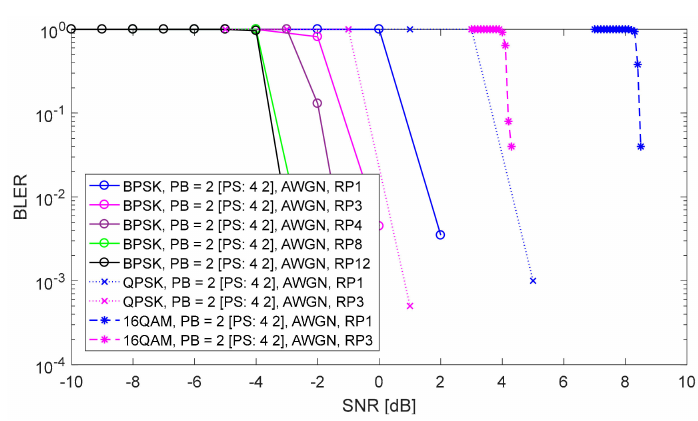
Figure 8. BLER curves for P B 0 [same scenario as non-PA].